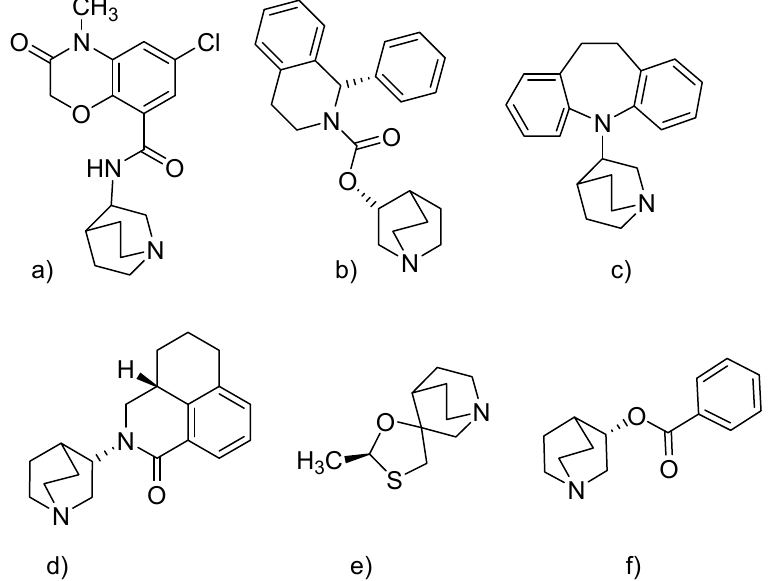
Figure 1. Quinuclidine-3-yl-based drugs: ( a ) Azasetron; ( b ) Solifenacin; ( c ) Quinupramine; ( d ) Palonosetron; ( e ) Cevimeline; and ( f ) Benzoclidine.